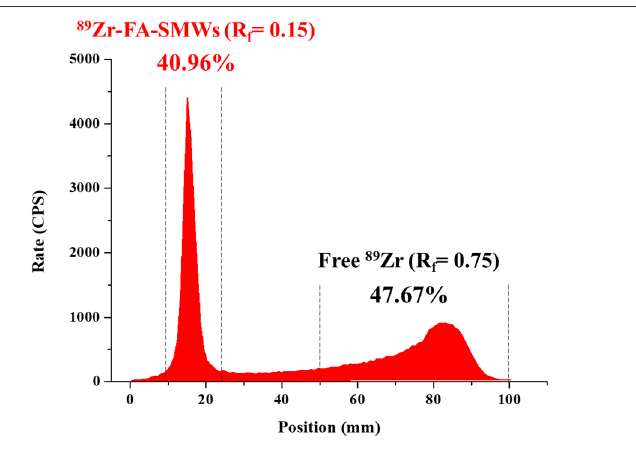
Figure 6. The labeling yield of 89 Zr-FA-SMWs was confirmed using radio-TLC. 89 Zr labeled FA- SMWs (40.96%) and free 89Zr (47.67%) were displayed using i-TLC-SG (1.0 × 10 cm 2 ) as the solid phase and the 50 mM of DTPA as the mobile phase.